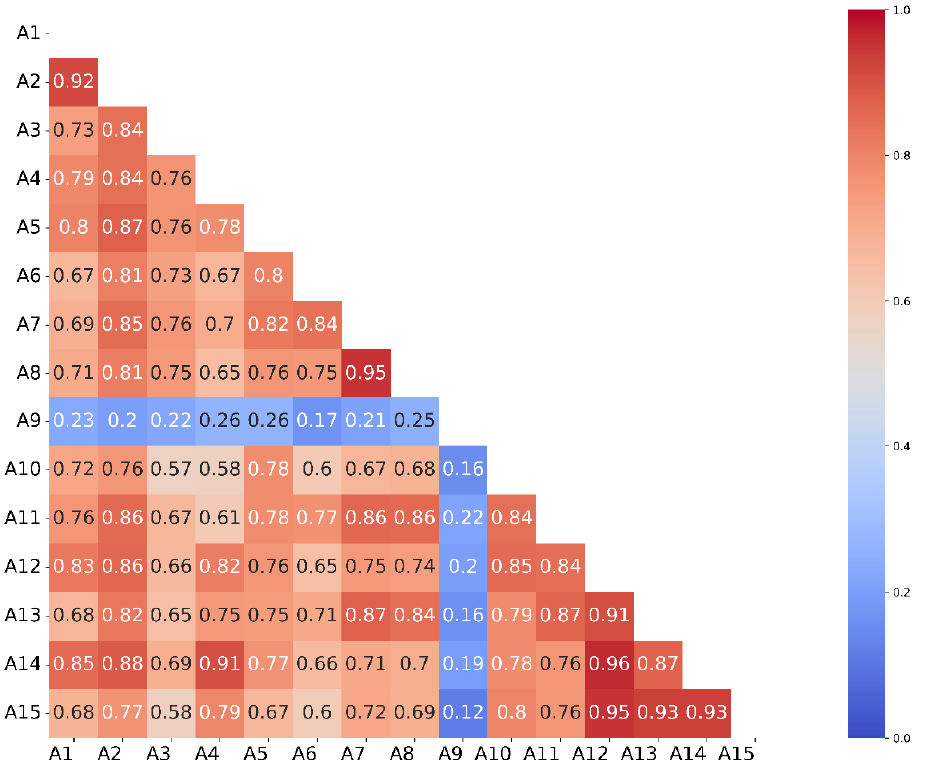
Figure 6. Correlation matrix for locations A1–A15.